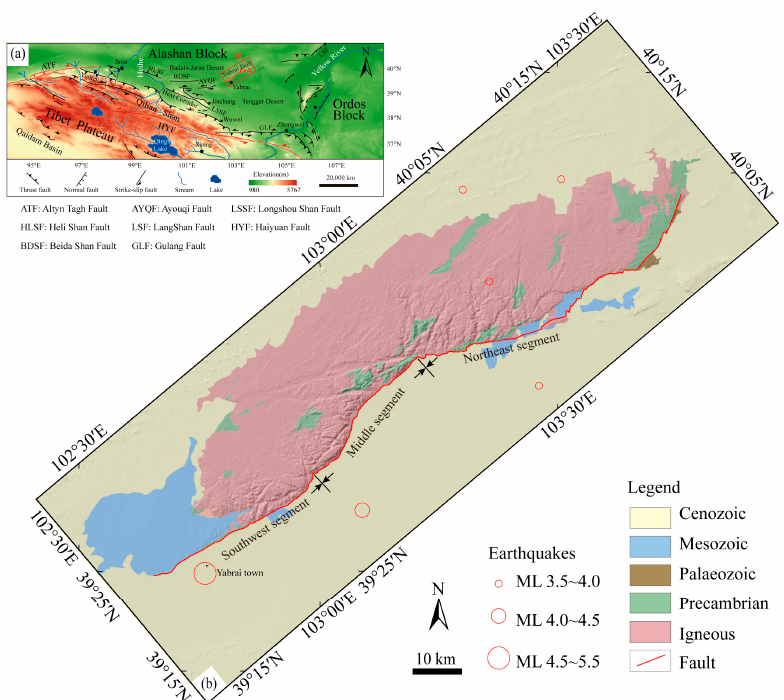
Figure 1. ( a ) Topography and major active faults in the northeast Tibetan Plateau, modified from [6,12]. ( b ) The geological map of Yabrai Shan. The red boxin ( a ) shows the location of Yabrai Shan. The red line and red circles in ( b ) represent the Yabrai range-front fault and seismicity in this area. Fault data from [12,26] and seismicity data from CENC and USGS catalogue.